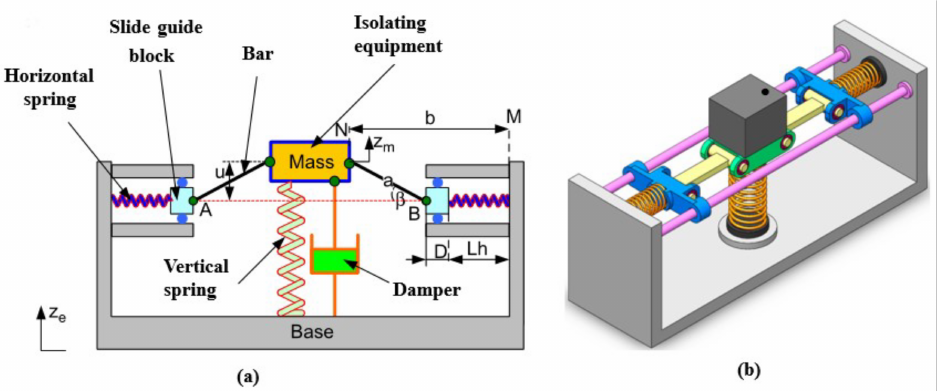
Figure 6. Schematic diagram of spring-rod structures in ( a ) Spring connecting rod structure. Reprinted/adapted with permission from Ref. [56]. Copyright 2013 Elsevier Ltd., Kyoung KwanAhn and Thanh DanhLe. and ( b ) Three dimensional quasi zero stiffness isolator. Reprinted/adapted with permission from Ref. [57]. Copyright Springer Nature B.V. 2020, Chaoran Liu and Kaiping